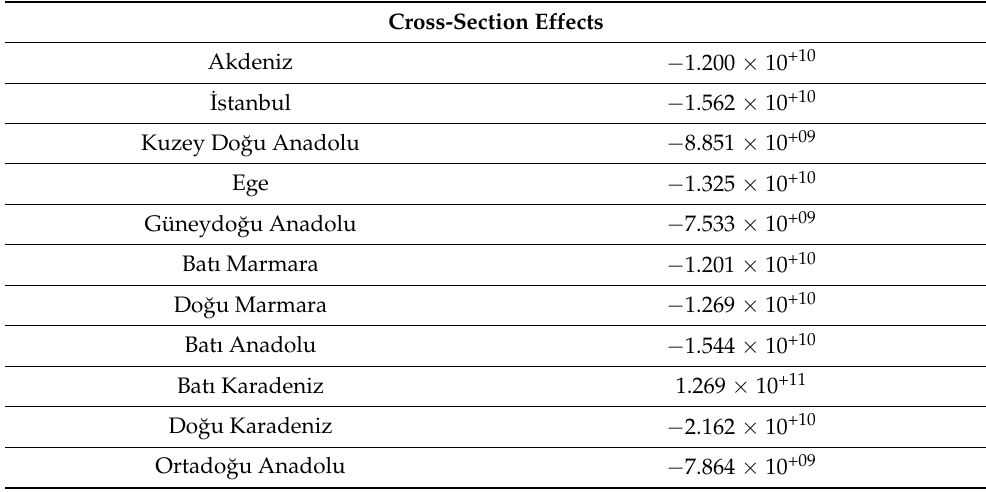
Table 8. Cross-section effects in Turkish